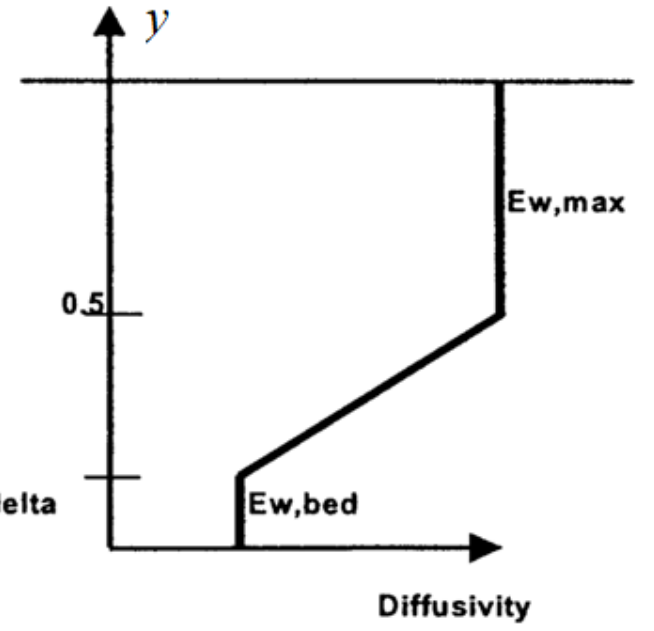
Figure 2. Vertical distribution of wave-related sediment diffusivity in the bottom boundary layer (adapted with permission from [38]).